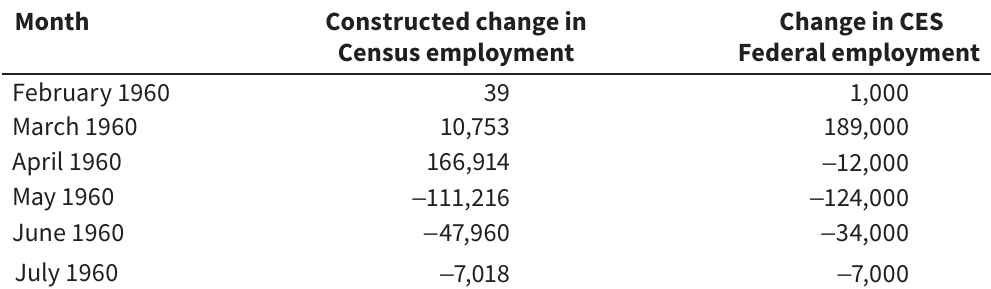
Discrepancies in 1960